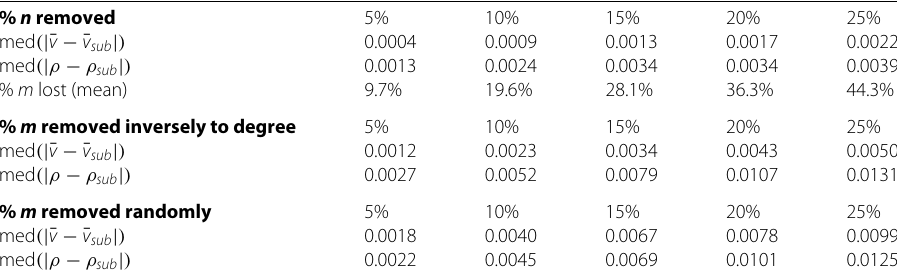
Table 5 Median robustness of normalised degree variance, ¯ v , and heterogeneity, ρ , to subsampling across 184 real-world